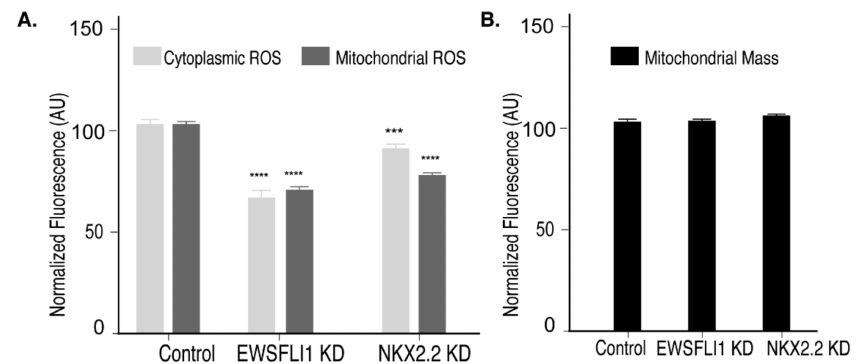
Figure 5. NKX2.2 regulates STEAP1 function: Measurement of cytoplasmic and mitochondrial reactive oxygen species (ROS) in the modified HTB166 cell lines. ( A ) Cytoplasmic ROS was measured using dihydroethidium fluorescence shown as light grey bars. Mitochondrial ROS, shown as dark grey bars, was measured using MitoSox staining. ( B ) The measurement of mitochondrial mass obtained by Mito Tracker green, shown as black bars, to confirm that the mass of mitochondria does not change between control and KD cell lines. The controls (unmodified cell lines) are set as 100%, and the levels in KD cell lines were normalized to that of control. Each experiment was done in triplicate. The error bars represent standard deviation. *** p < 0.001, **** p <